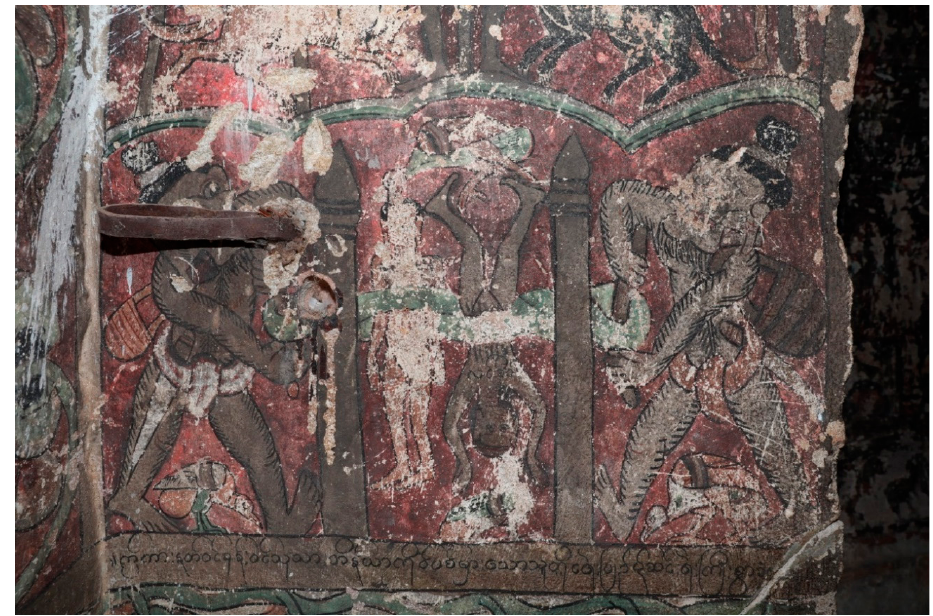
Figure 44. Powin Daung, Cave 480, 18th century. Punishment, among other things, for adultery.